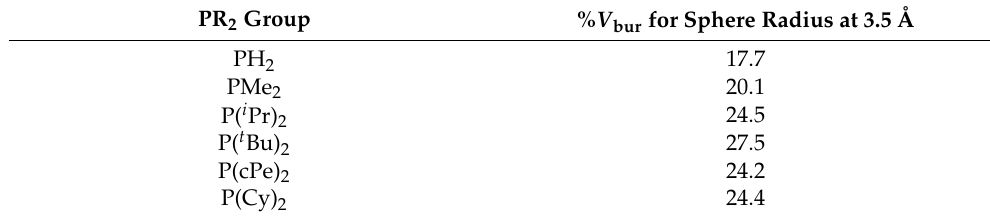
Table 2. Value of % V bur for the PR 2 group in the PNP ligand. PR 2